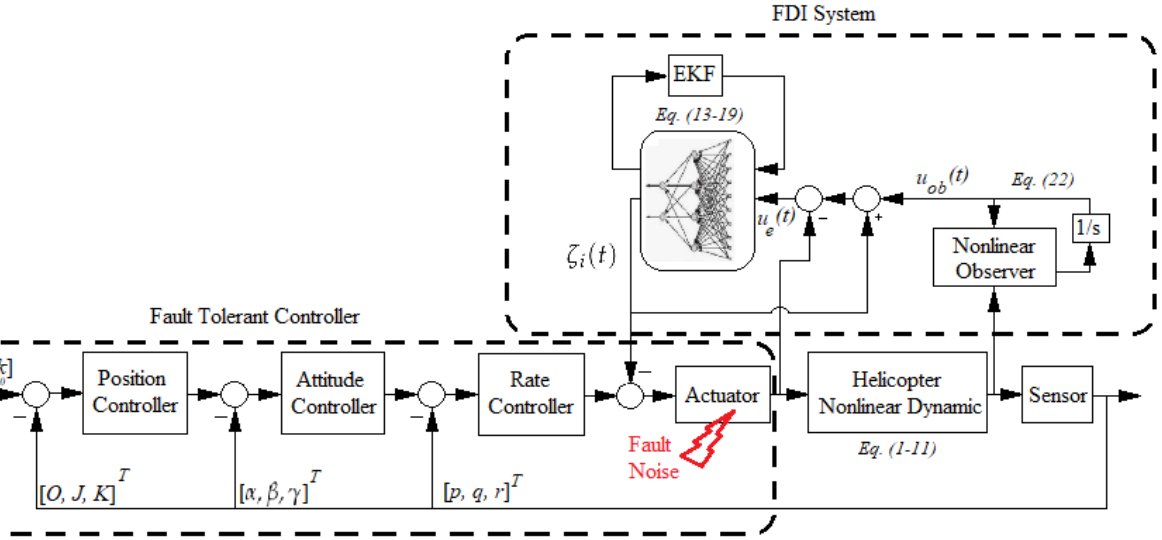
Figure 3. Proposed united framework for AFTC diagram of a